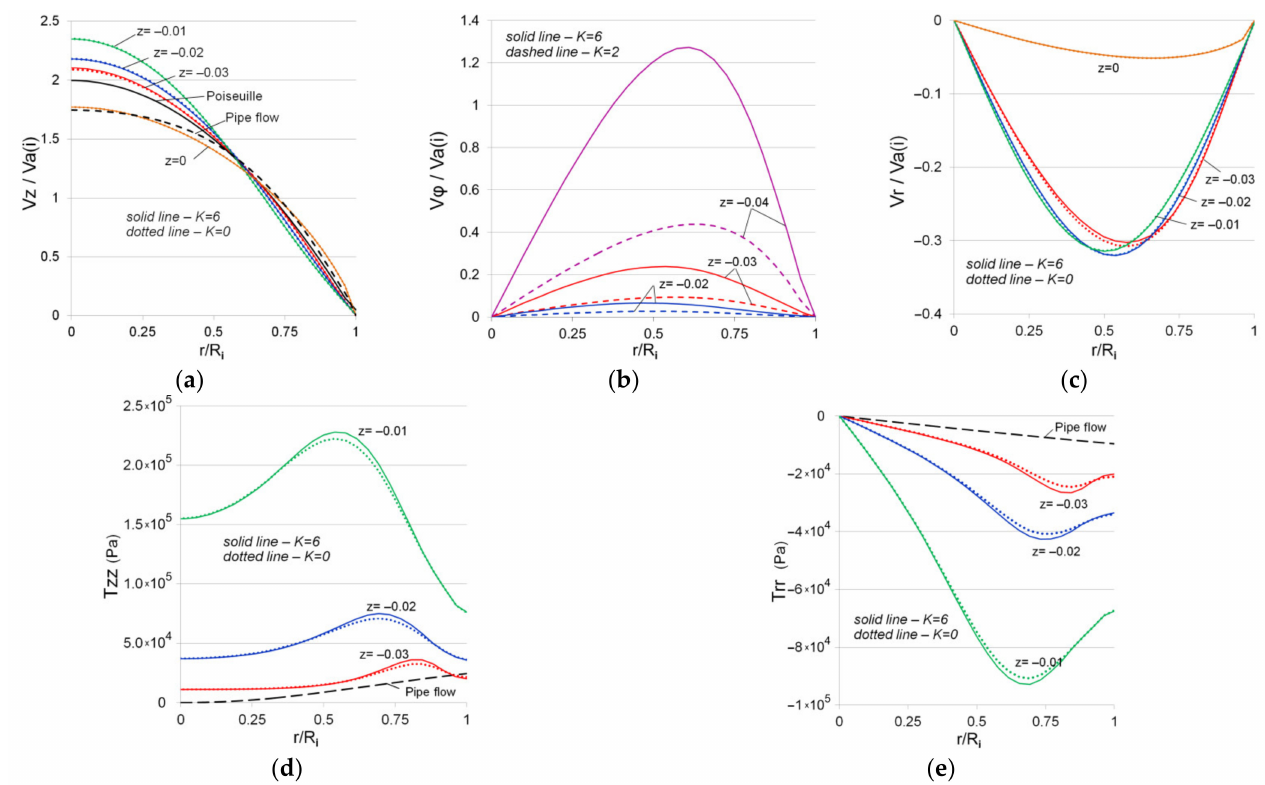
Figure 5. Normalized axial ( a ), circumferential ( b ) and radial ( c ) velocities distribution, normal stresses of extra stress tensor T ( d , e ) in the confusor for various initial swirl intensities, Wi = 5.04 (inlet) ( V a = 0.03 m/s at the